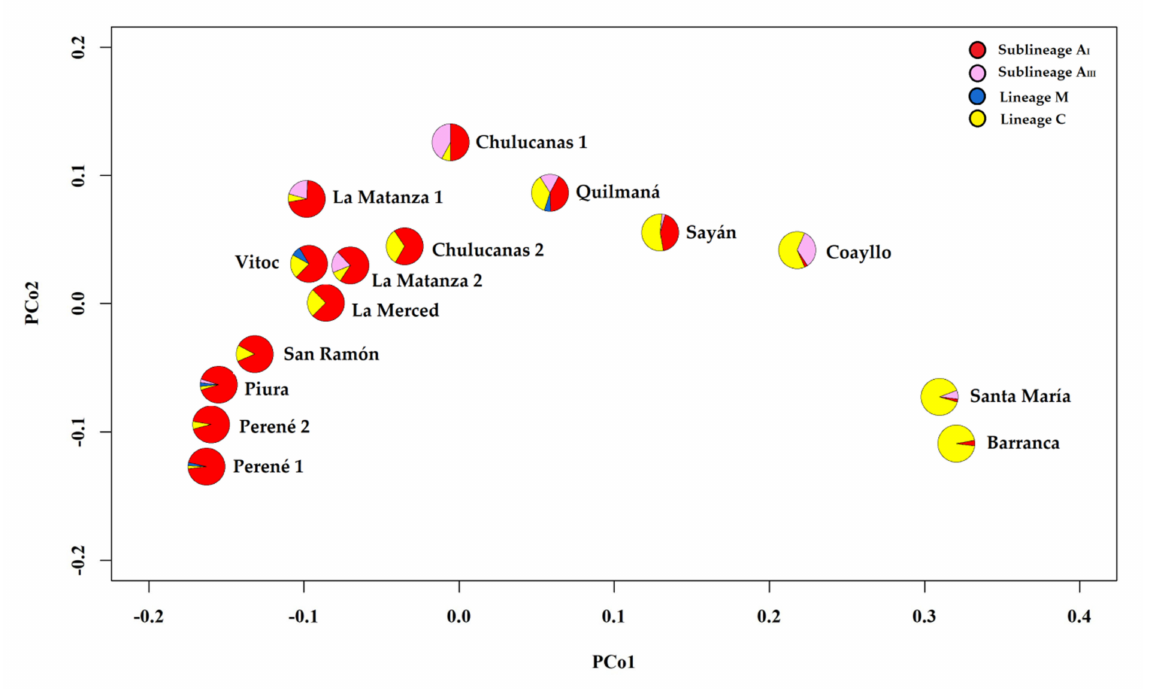
Figure 5. PCoA of sampling sites based on Φ PT matrix obtained with frequency data for lineages and African sub-lineages. Pie charts display the proportions of lineages and sub-lineages for each sampling